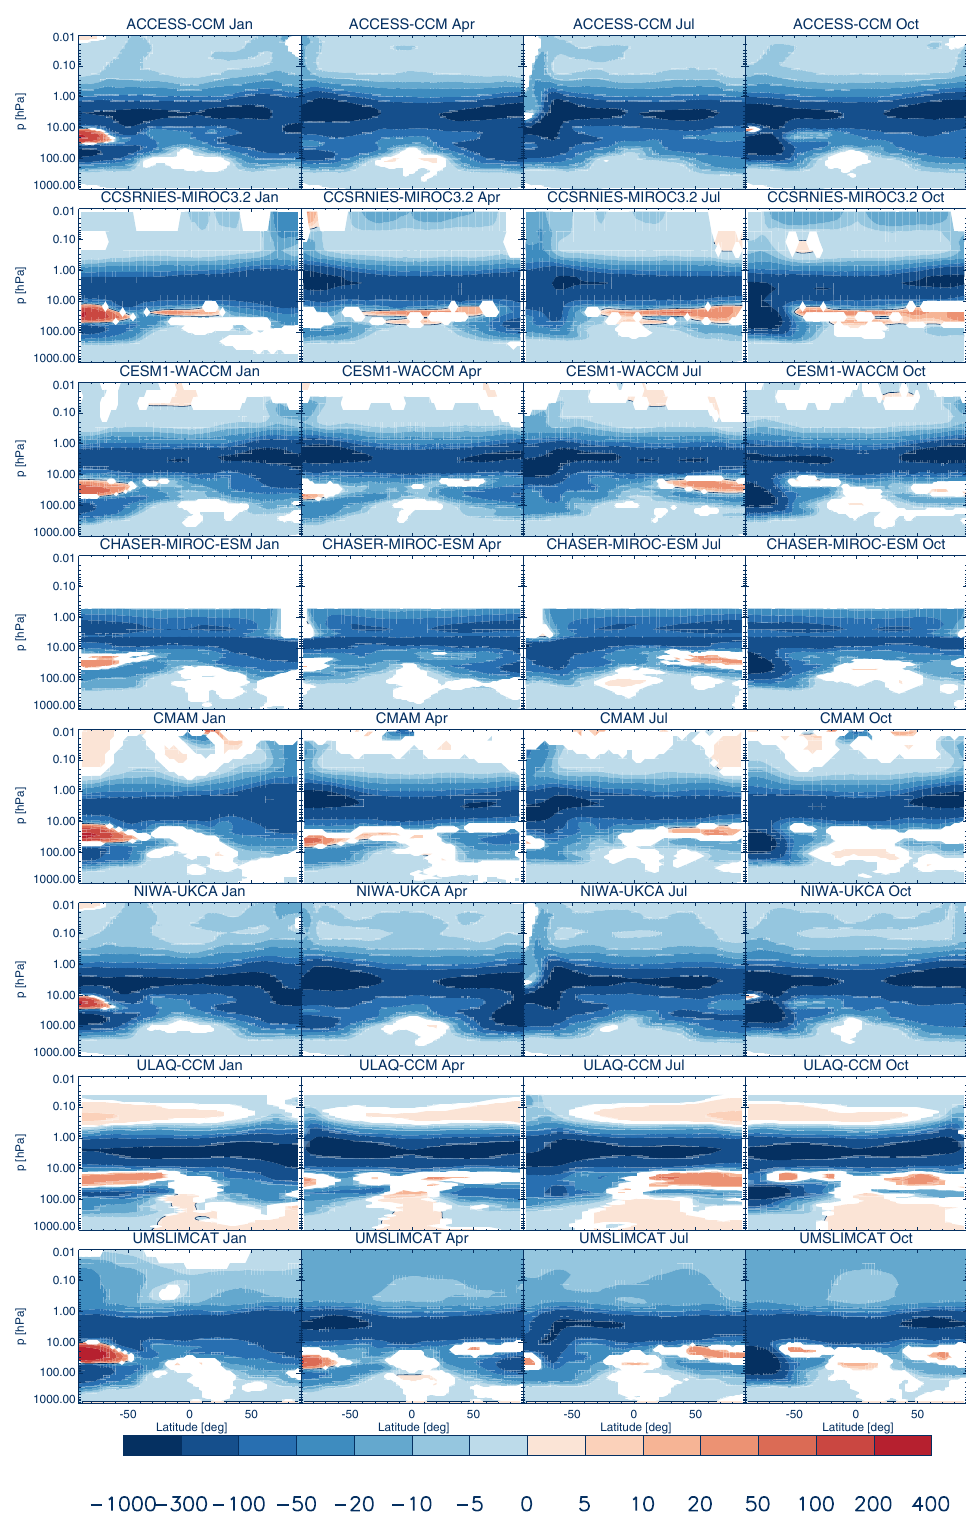
Figure 7. Same as Fig. 1 but for Cleq .